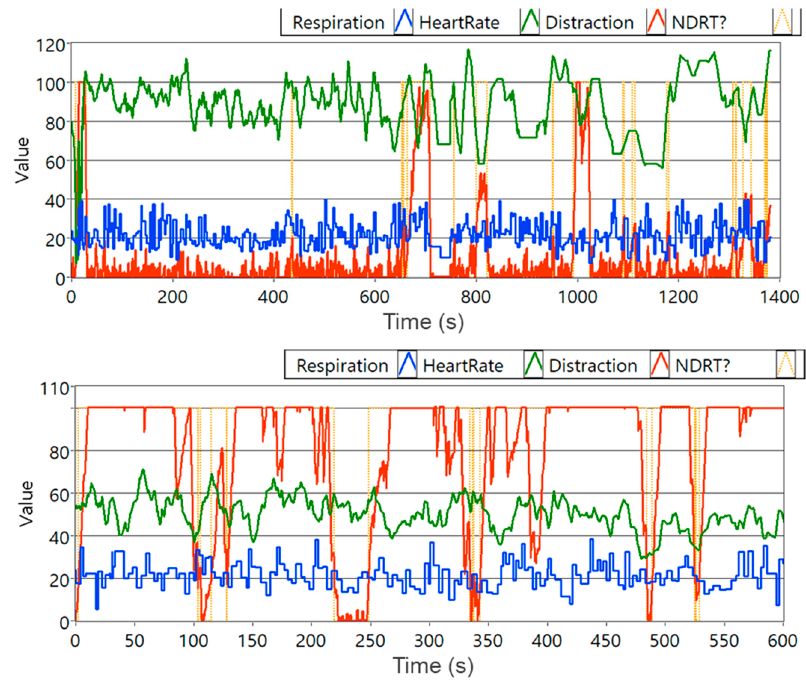
Figure 17. Heart rate, respiration rate, and NDRT concentration data.